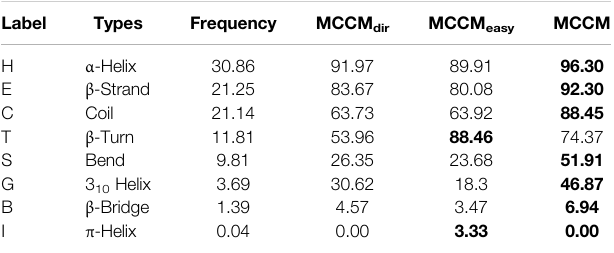
TABLE 3| Predictionaccuracy ofeach label intheQ8states based ontheCB513